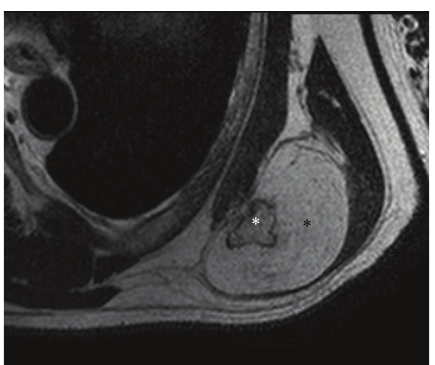
Figure 3: T2 fast spin echo axial image showing well-defined hyper- intense lesion (black asterisk) with the multilobulated hypointense bony excrescence (white asterisk) arising from inferior border of left scapula.